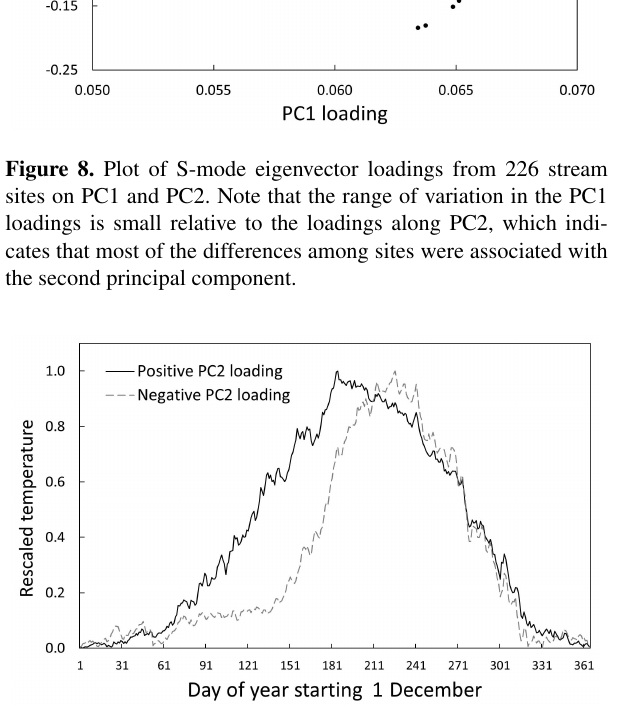
Figure 9. Annual water temperature timing patterns reconstructed from S-mode PCs using the mean eigenvector loading value for PC1 and ± 0 . 16 for PC2 to demonstrate the effects of strong negative loadings and positive loadings on PC2.